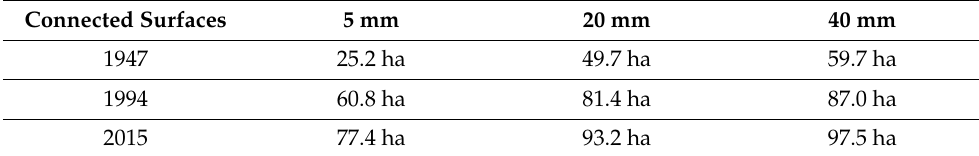
Table 3. Evolution of connected areas.